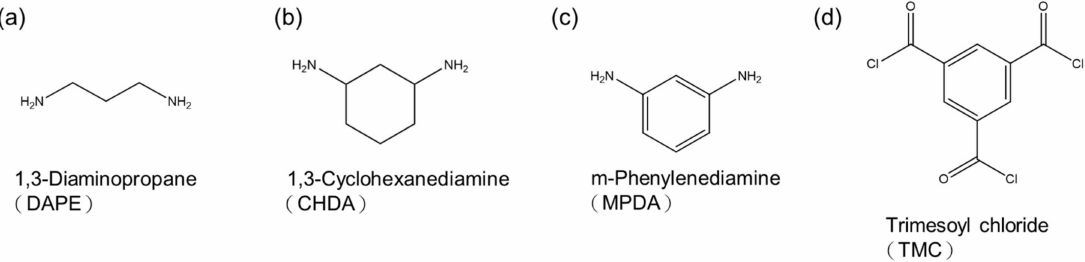
Figure 2. Chemical structure of monomers: ( a ) DAPE; ( b ) CHDA); ( c ) MPDA; ( d )